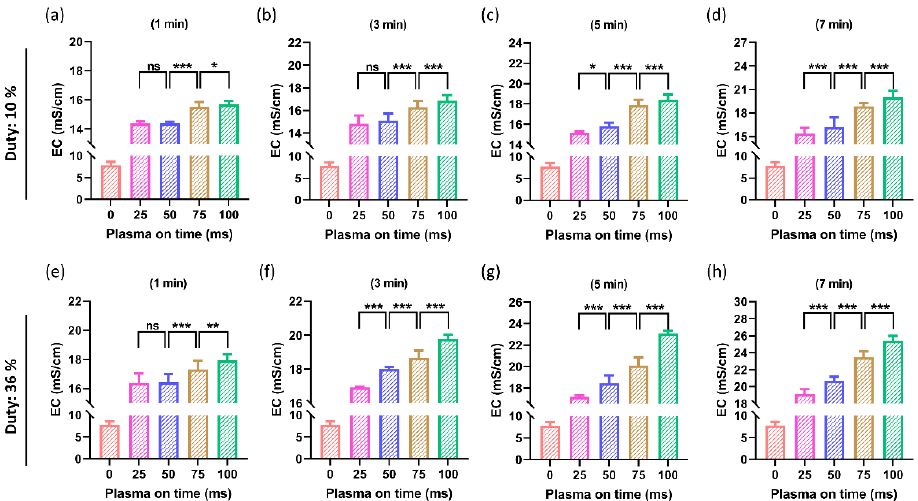
Figure 4. The EC of PTM (DMEM). ( a – d ) The EC when the duty ratio was set to 10% and ( e – h ) when the duty ratio of 36%. The EC of the PTM significantly increased by increasing the plasma on-time. The significance was calculated using Microsoft Excel (MS Office 365), while the differences between the treatment groups are indicated by * p < 0.05, ** p < 0.01, *** p < 0.001, ns—not significant.